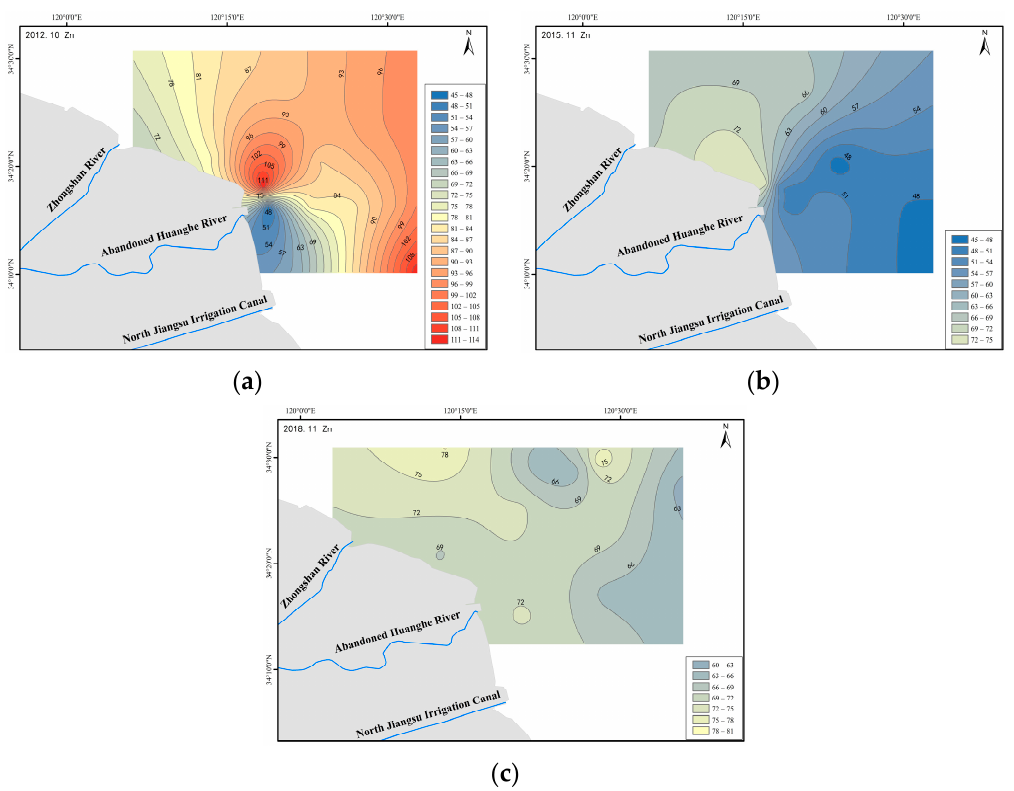
Figure 8. Spatial distribution of Pb in sediments. ( a ) 2012; ( b ) 2015; ( c ) 2018. The high-value zone of Zn had a significant expanding trend in the three sets of mon- itoring data, which was consistent with the distribution of the wind farm area (Figure 9).